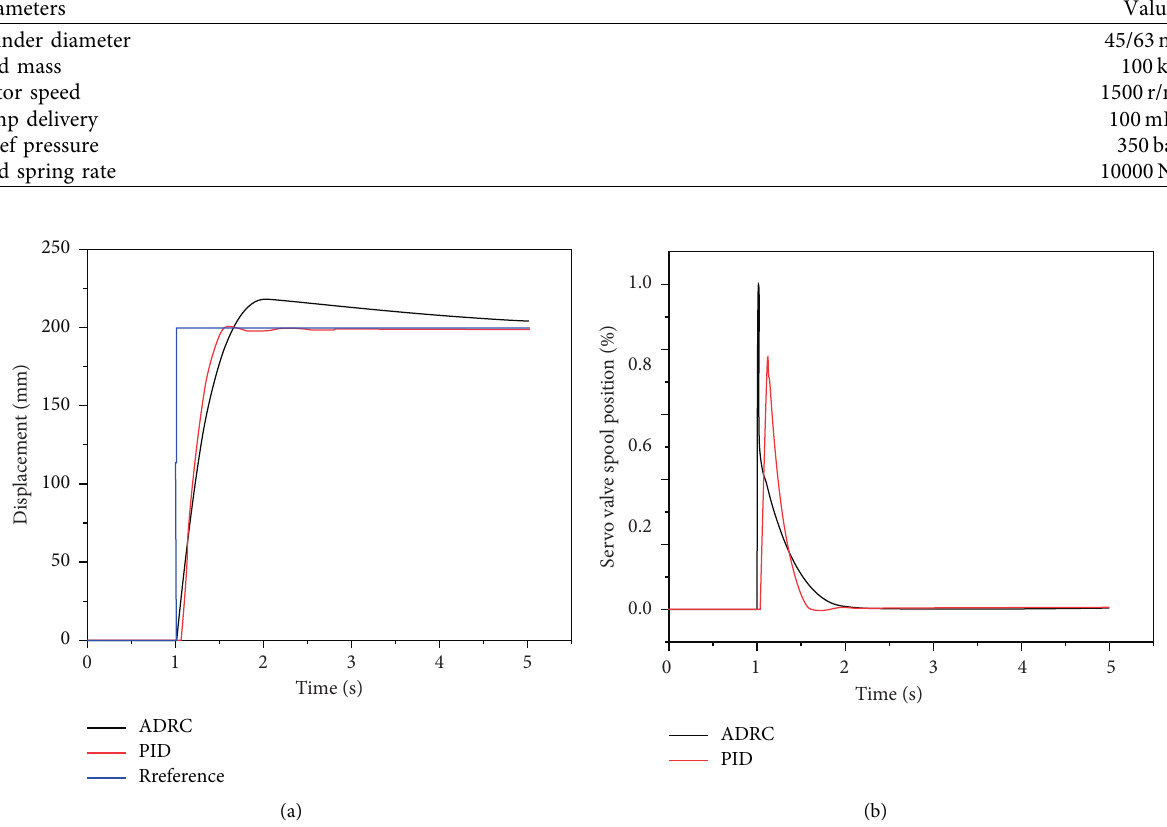
Figure 6: Step responses in ADRC and PID under constant load. (a) Cylinder displacement response. (b) Spool position response.